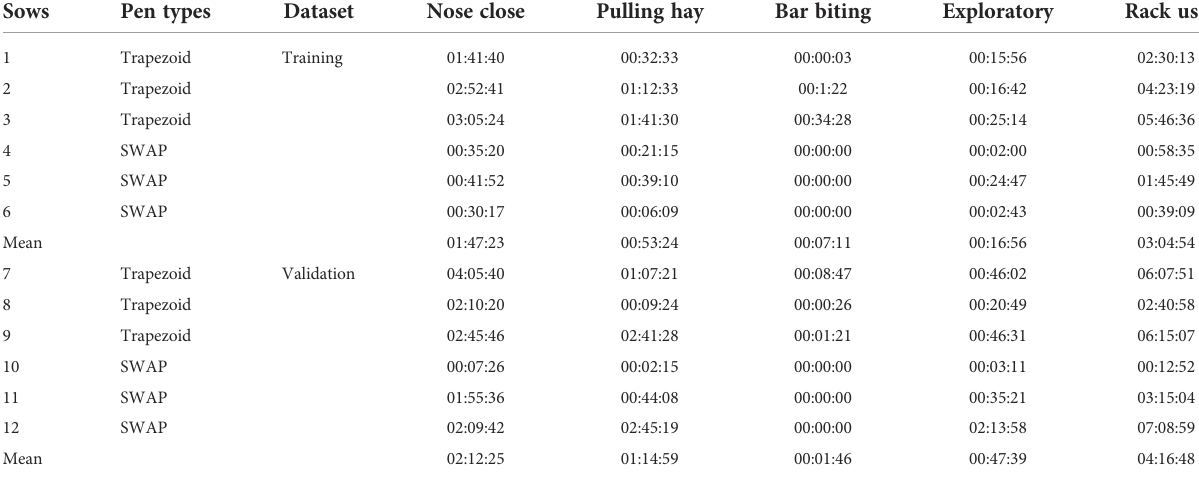
TABLE 2 Results of labeling of hay rack use behaviors.